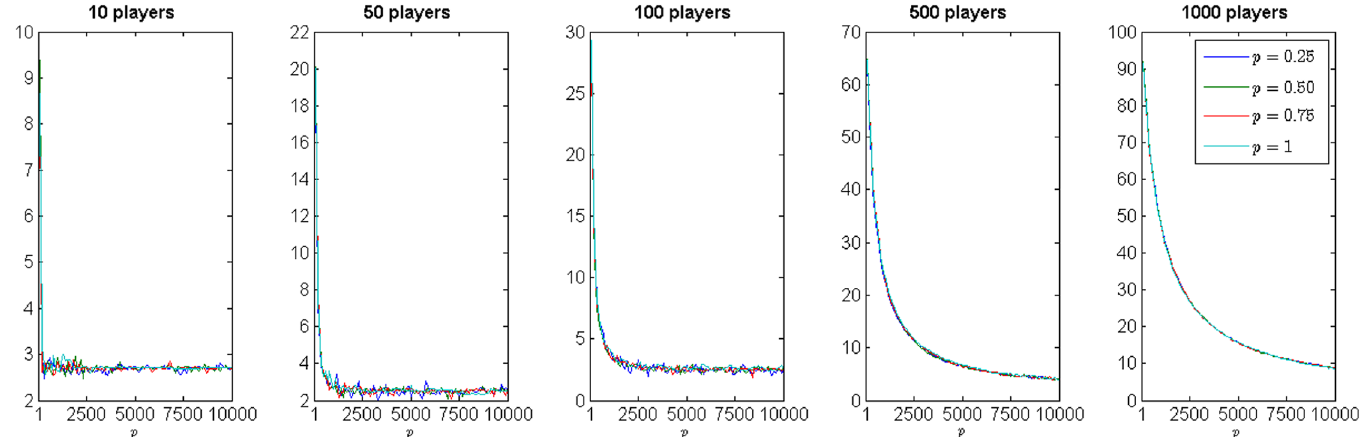
Fig 4. Evolution of the distance to NE in all cases:again no significant diference between the four p values is observed.